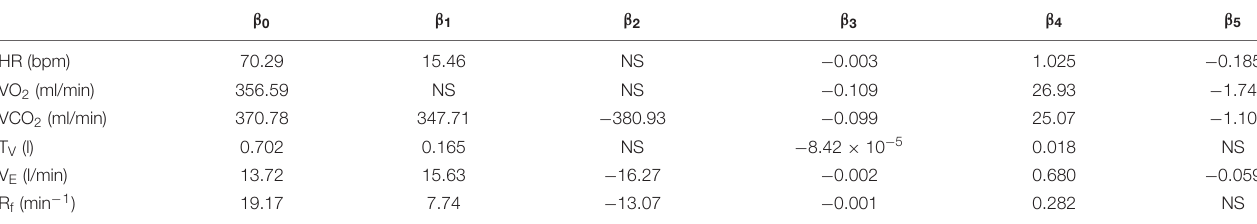
TABLE 2 | Regression coefficients for cardiopulmonary variables based on the following equation: y ij = β 0 + β ∗ 1 AG 2 + β ∗ 2 AG + β ∗ 3 WR 2 + β ∗ 4 WR + β ∗ 5 AG ∗ WR + u i + ε ij .